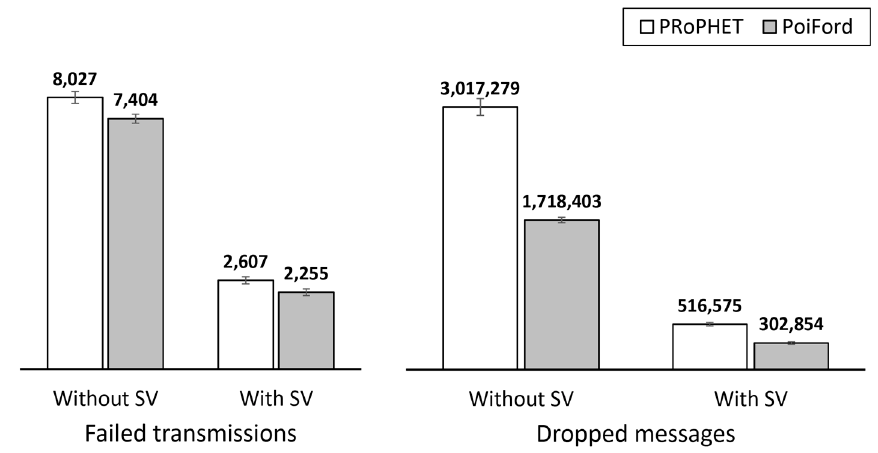
Figure 12. Number of failed transmissions (aka. aborted messages in ONE simulator) and number of dropped messages for PRoPHET and PoiFord.